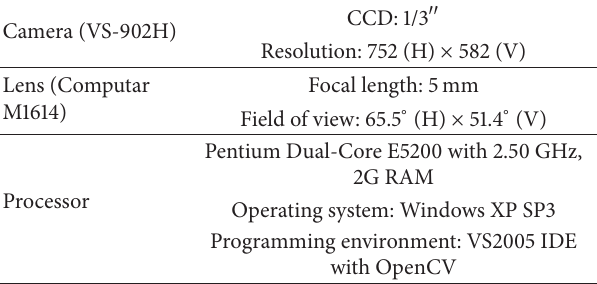
Table 1: The composition of visual perception